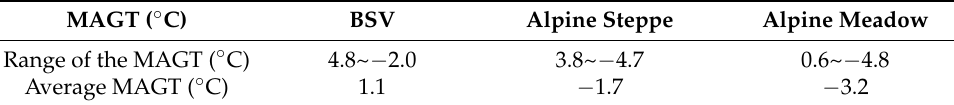
Table 8. The MAGTs and average MAGTs of soil layers with different vegetation cover in the Gaize